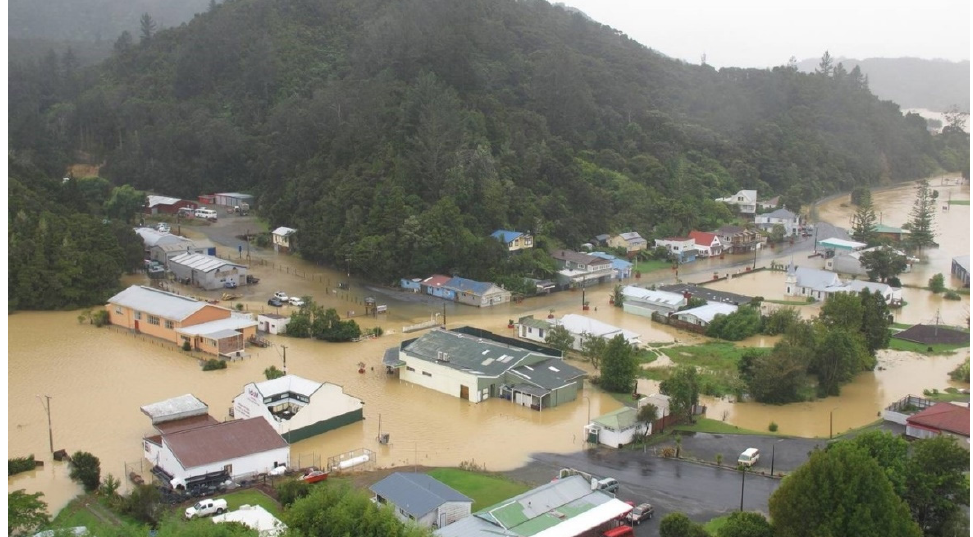
Figure 1. Flood impacts in the Northland (Source: Kaeo Library, Northland, New Zealand).